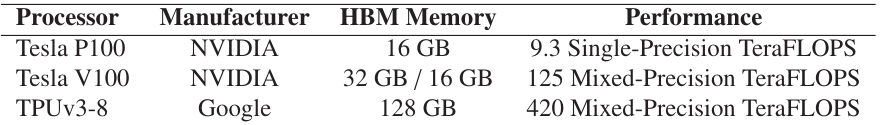
Table 3. Comparison of NVIDIA Tesla P100 [19], Tesla V100 [20], and Google TPUv3-8